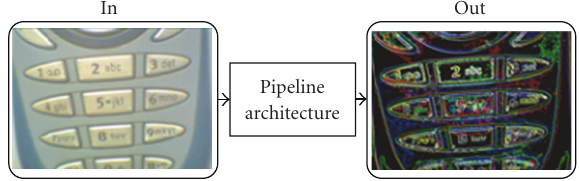
Figure 15: Emulation result of the Photoshop’s Glowing Edge filter applied to a color